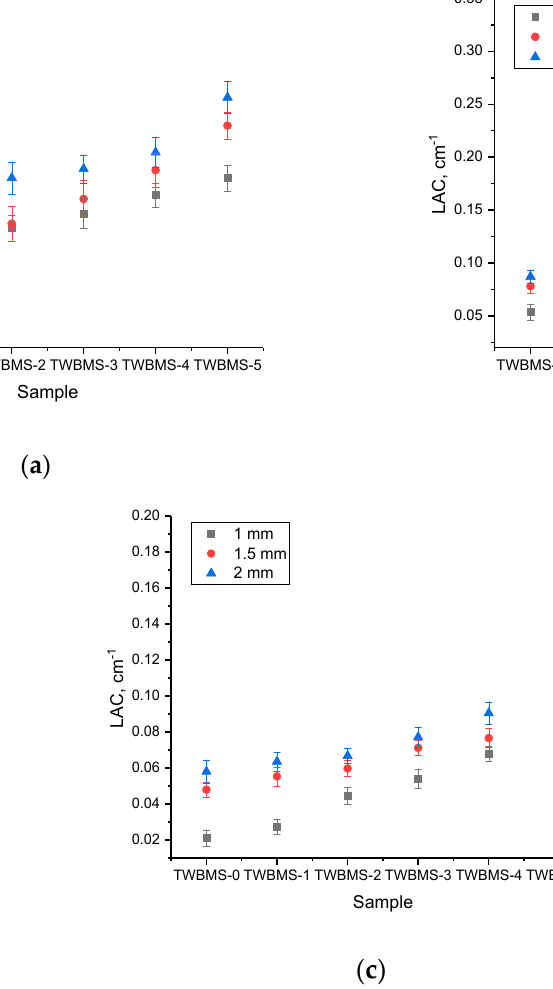
Figure 4. Results of evaluation of the change in the linear attenuation coefficient of gamma radiation depending on the type of gamma-quantum source: ( a ) Co 57 , 130 keV; ( b ) Cs 137 , 660 keV; ( c ) Na 22 , 1270 keV.